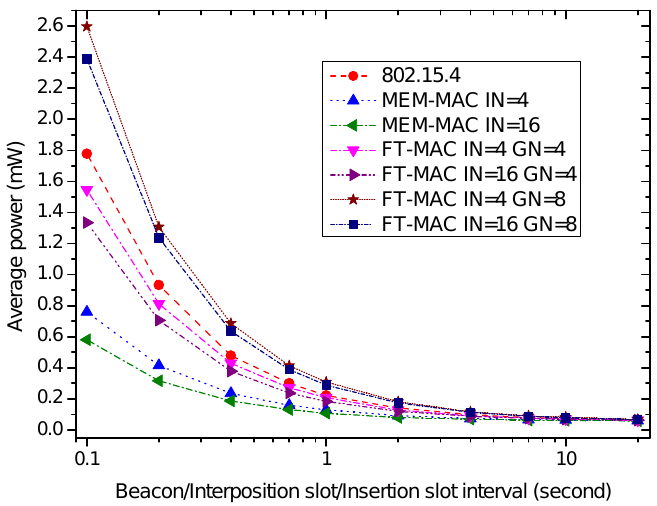
Figure 18. The effect of the beacon/interposition/insertion intervals on coordinator average